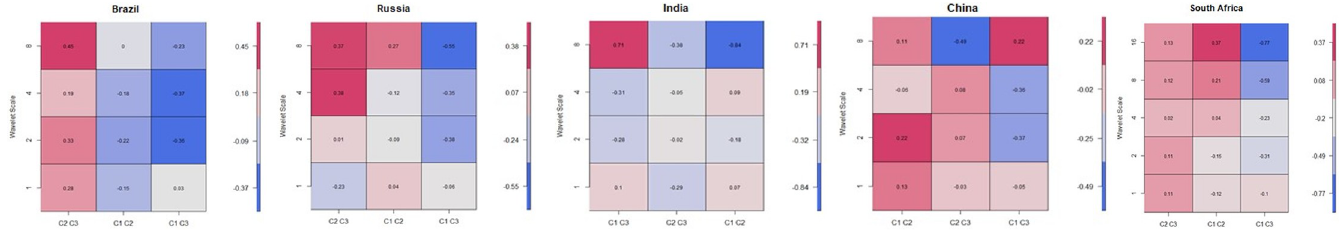
Fig 3. Wavelet bivariate correlations matrix. Wavelet bivariate correlations matrix. The codes for the variables are GEPU (C1), GDP (C2) and RFSI (C3).